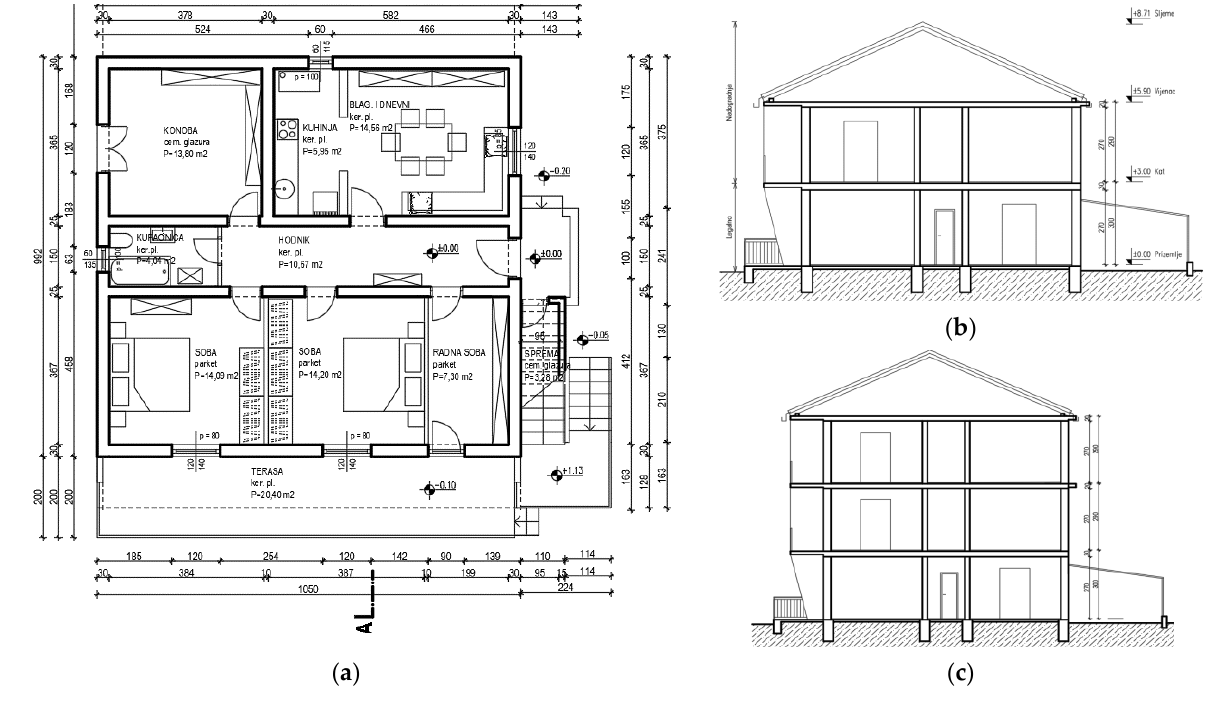
Figure 11. Typical configurations outside of the historical center: ( a ) plan; ( b ) section view P + 1; ( c ) section view P + 2.